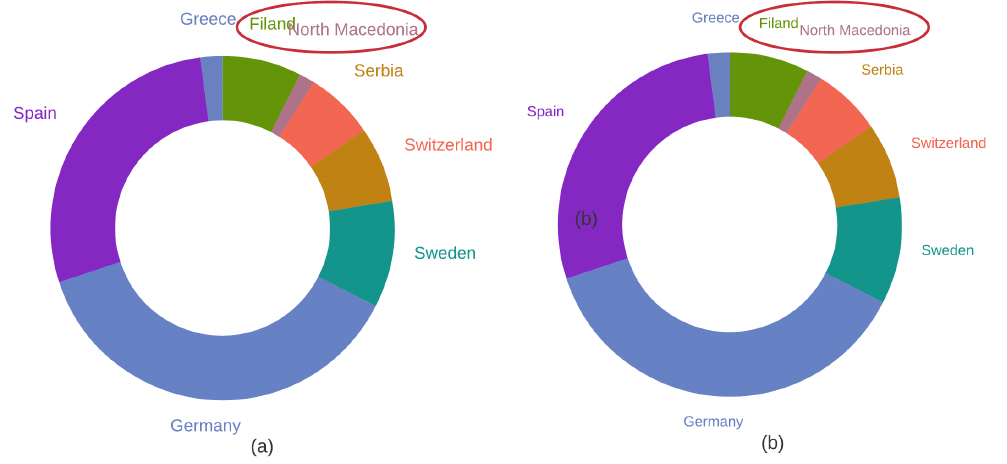
Figure 10. Example of removing overlap using global font size change : ( a ) before use; ( b ) after